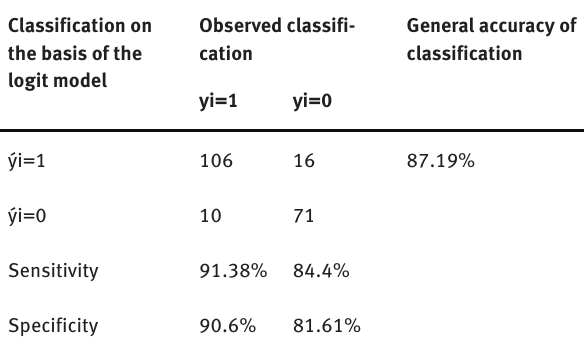
Table 12: Accuracy of classification according to the logit model.